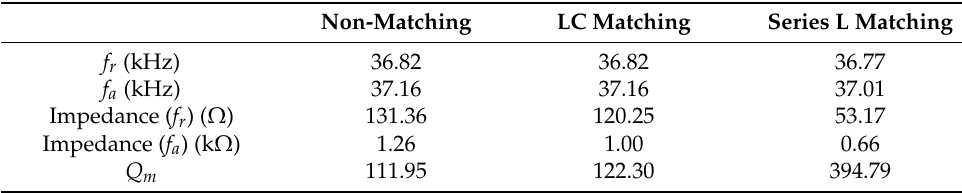
Table 2. Experimental results under different matching